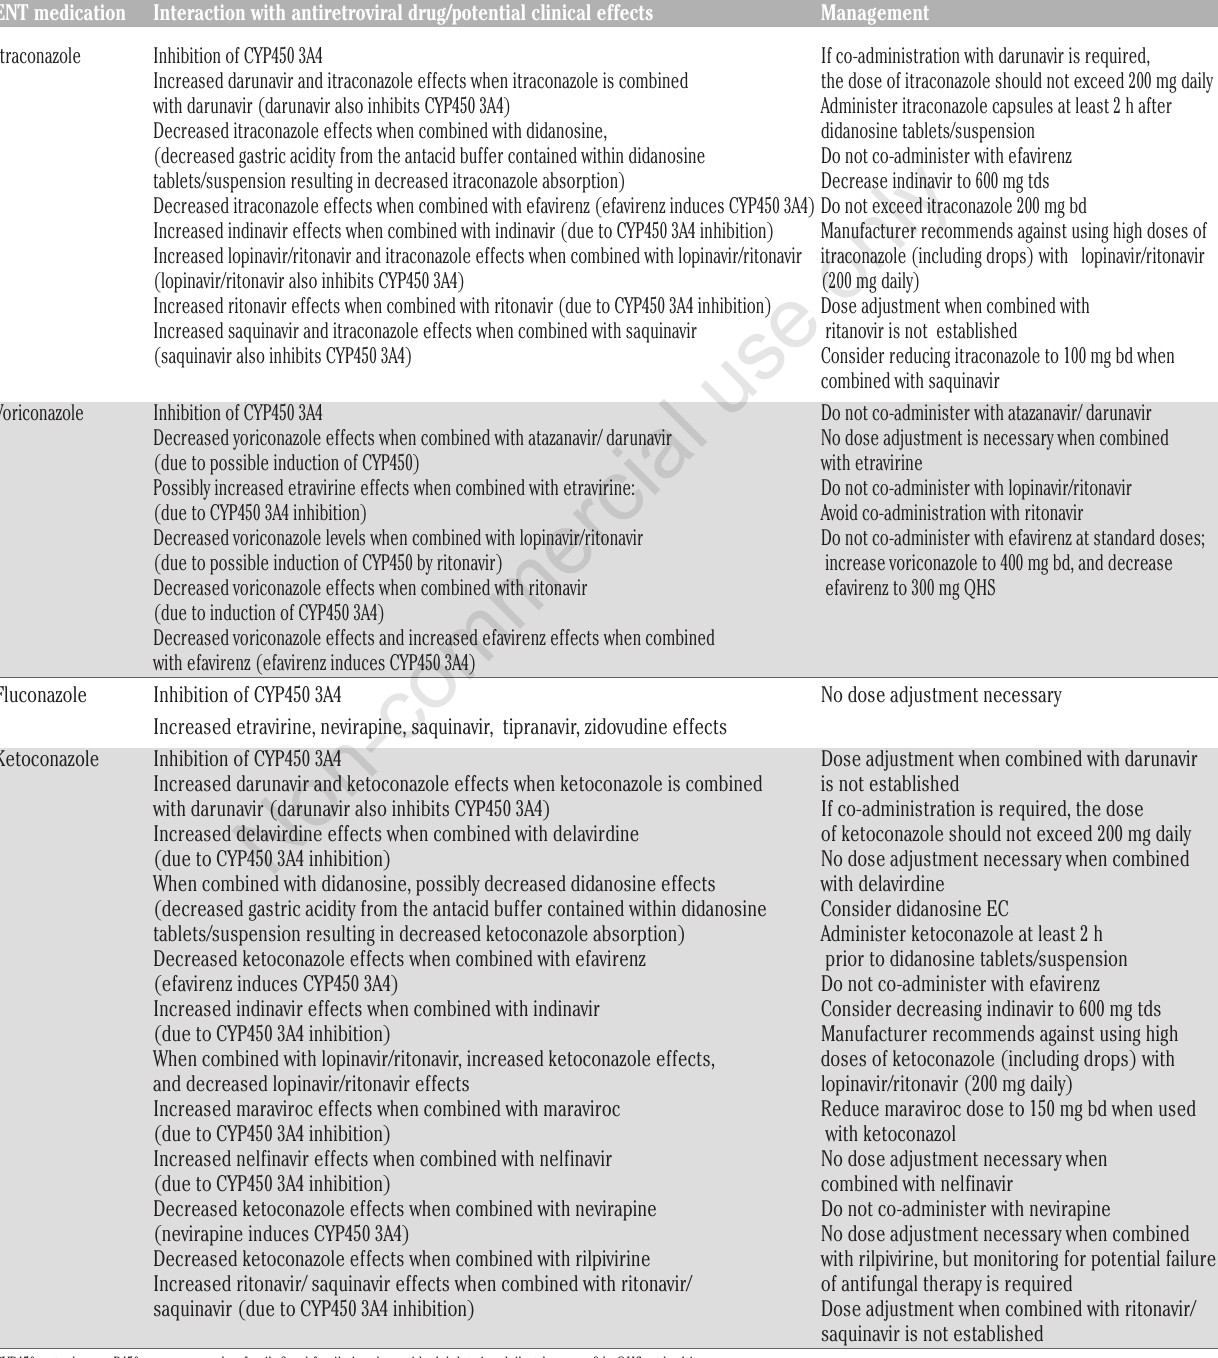
Table 3. Interactions between commonly administered ear, nose and throat medications and antiretroviral drugs. 73 ENT